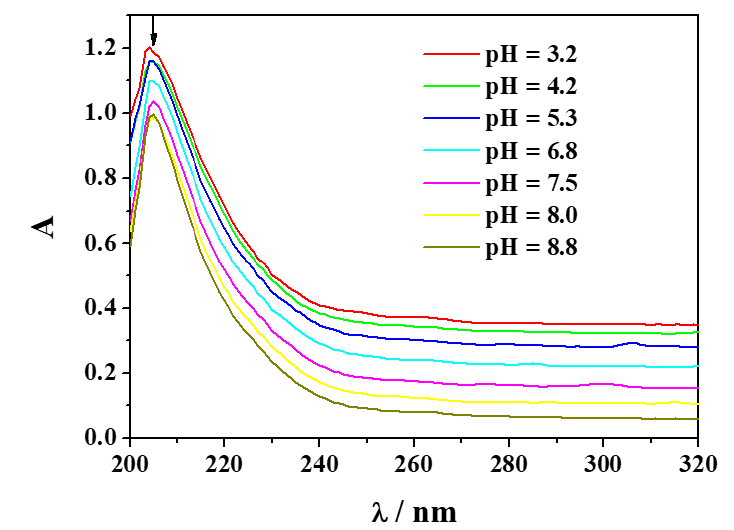
Figure 3. Experimental spectra at different pH on solutions containing Mn 2+ (M) and Amp (L) at C M = 0.05 mmol L − 1 and C L = 0.05 mmol L − 1 , t = 25 °C, I = 0.15 mol L − 1 in NaCl.